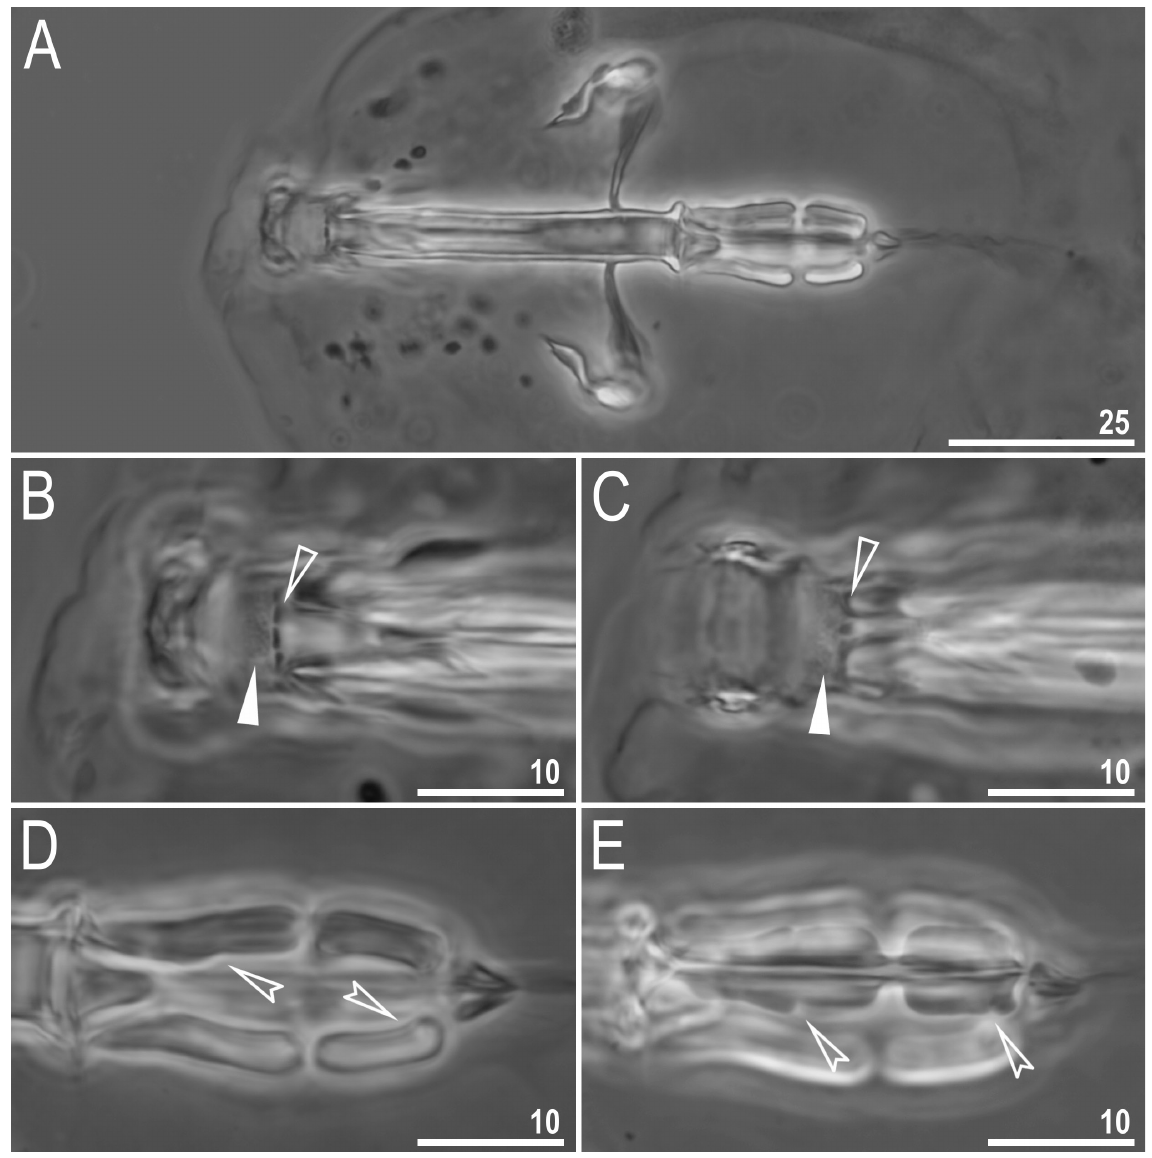
Fig. 5. Macrobiotus engbergi sp. nov. Buccal apparatus and the oral cavity armature seen in PCM (holotype, IZiBB, slide GL.052.22). A . Dorso-ventral projection of the entire buccal apparatus. B – C . Oral cavity armature visible in dorsal (B) and ventral (C) view, respectively. D – E . Placoid morphology visible in dorsal (D) and ventral (E) view, respectively. Filled flat arrowheads indicate the second band of teeth in the oral cavity, empty flat arrowheads indicate the third band of teeth in the oral cavity, empty indented arrowheads indicate central constrictions in the first macroplacoids and subterminal constriction in the second macroplacoids. Scale bars in